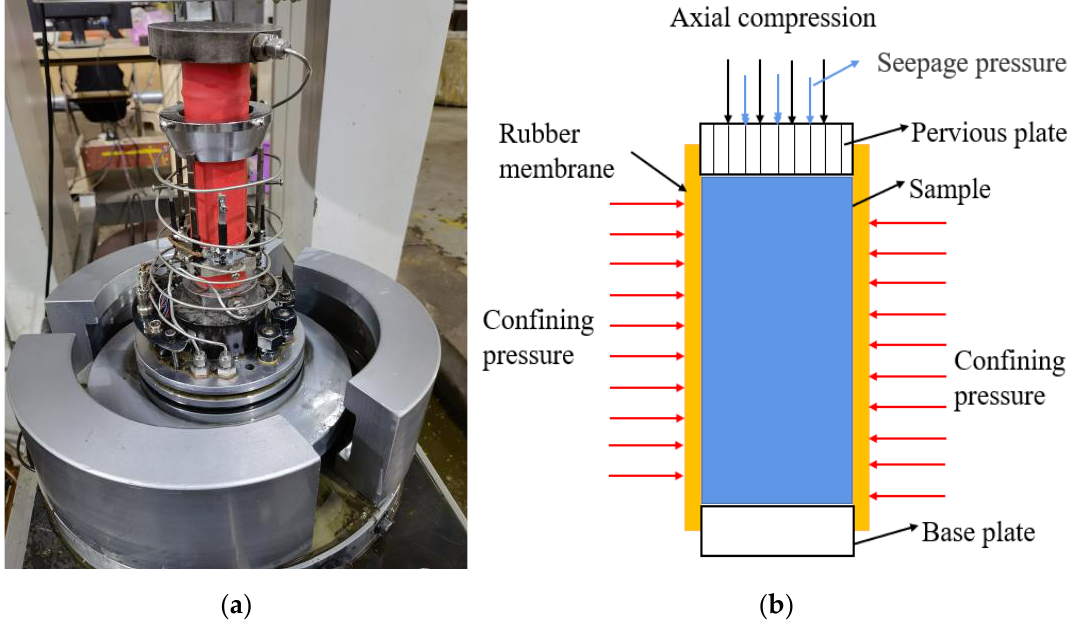
Figure 6. Schematic diagram of the hydraulic-mechanical coupling test: ( a ) installation drawing of sample, ( b ) schematic of pressure